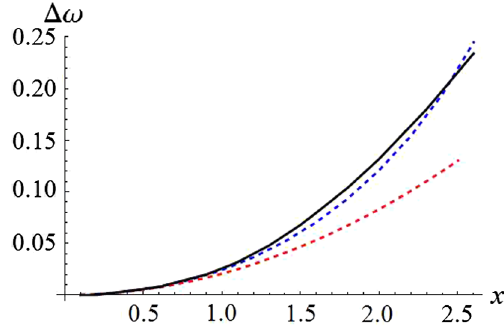
FIG. 2. The frequency shift, as function of initial x , calculated from numerical integration of Eq. (2.1) (black solid line) compared with the Landau formula Eq. (2.11) (red dashed line), and third order square matrix calculation (blue dashed line), ω 1 , α ¼ 0 . 2 , β ¼ 0 . 1 0 ¼